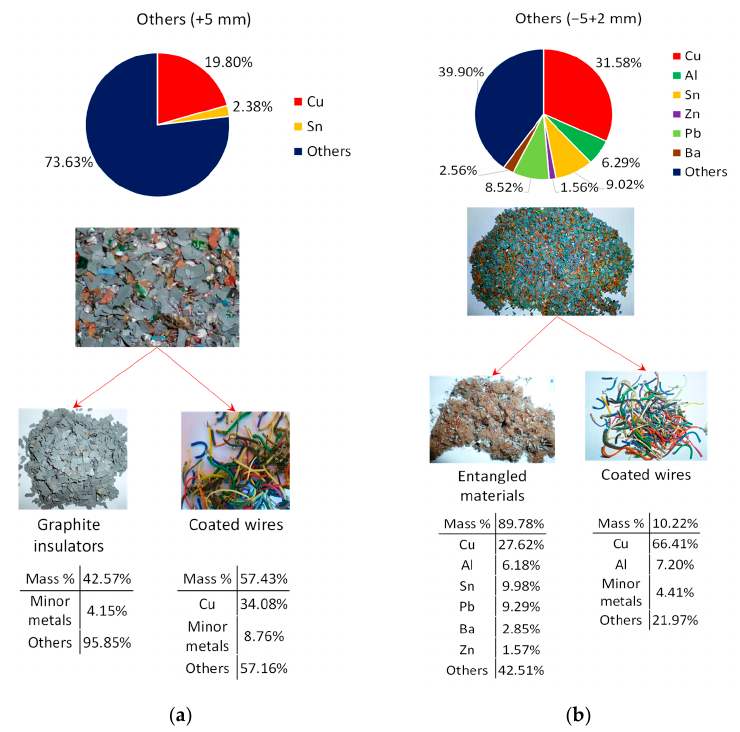
Figure 10. Elemental composition and pictures of residues separated in the +2.8 g/cm³ fraction. ( a ) +5 mm; ( b ) − 5 + 2 mm. “Minor metals” consider the sum of the elements Cu, Al, Fe, Sn, Zn, Pb, Ba, Mn, and Ni when not individually displayed. “Others” consider the sum of non-metallic elements and trace metals.